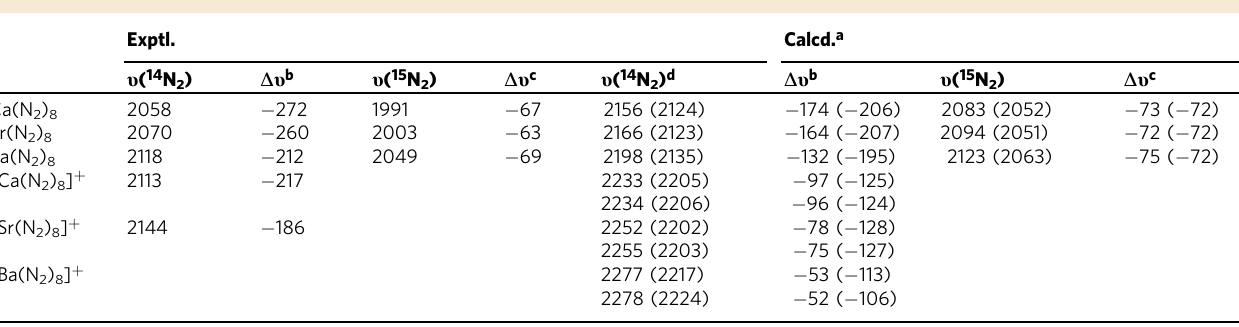
Table 1 Experimental and calculated IR-active N – N stretching frequencies υ of M(N 2 ) 8 and [M(N 2 ) 8 ] + (M = Ca, Sr, Ba) and frequency shifts Δ υ (cm − 1 ) Exptl.